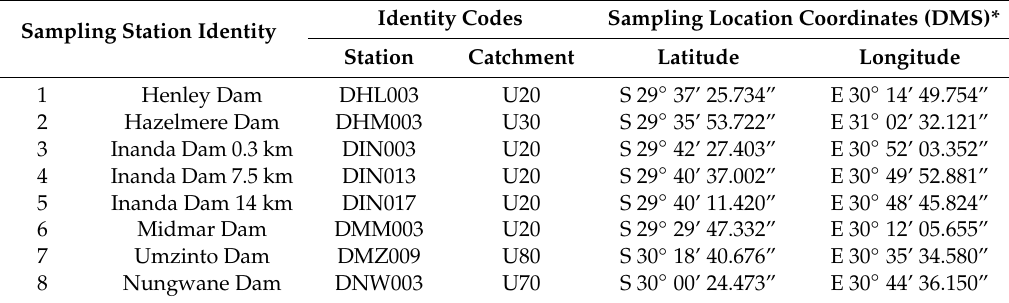
Table 2. Details of Sampling Stations Relevant to the